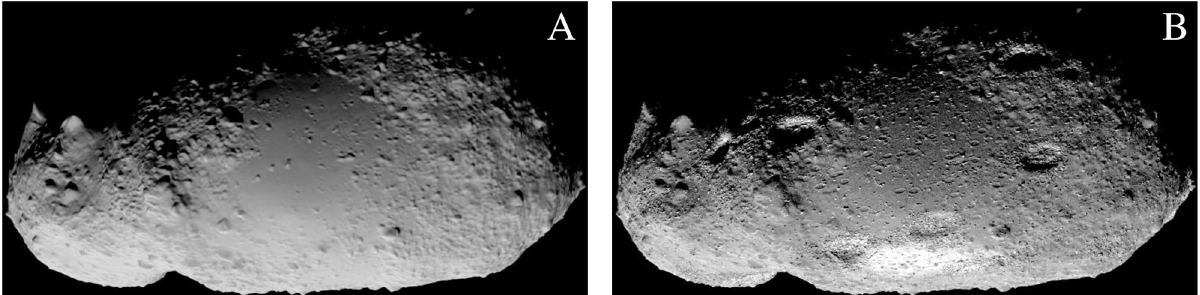
Fig 7. Surface mesh of asteroid 25143 Itokawa. Created by the AMICA imaging team [14] and rendered by authors in Blender Cycles. (A) plain mesh and (B) smooth mesh with procedural shader.